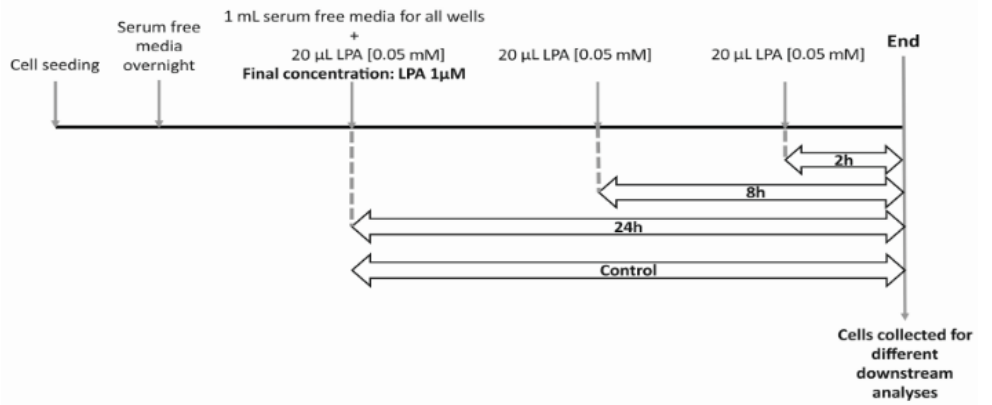
Figure 9. Schematic diagram of the experimental procedure. Cells were seeded and kept serum-free over-night. One mL serum free media was added to all wells and 20 µ L LPA [0.05 mM] was added at indicated times for a final concentration of 1 µ M. For 5 µ M LPA treatment, 1 µ L LPA [5 mM] was added to 1 mL media. At the end of the treatment, cells were collected for different downstream analyses.